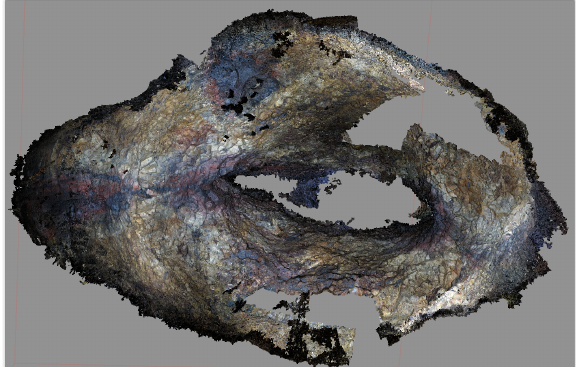
Figure 3. Dense point cloud model of the infrastructure of Thrihnukar volcano displayed in PhotoScan